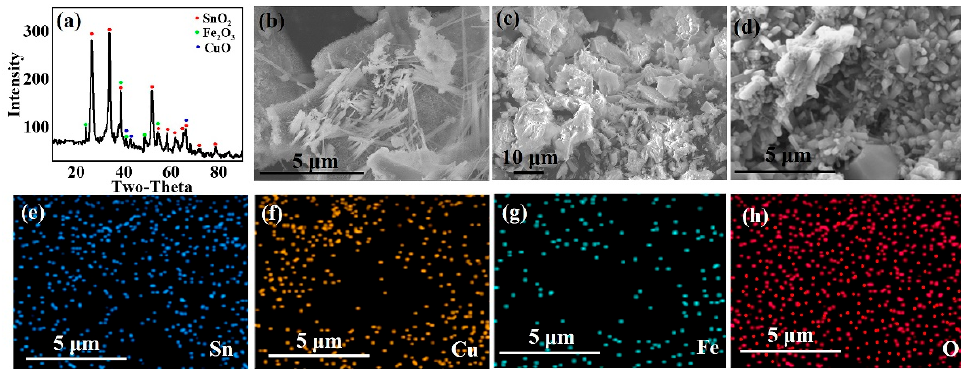
Figure 8. Characterization of calcinating product ( a ) XRD, ( b , c ) SEM, ( d – h ) EDS.